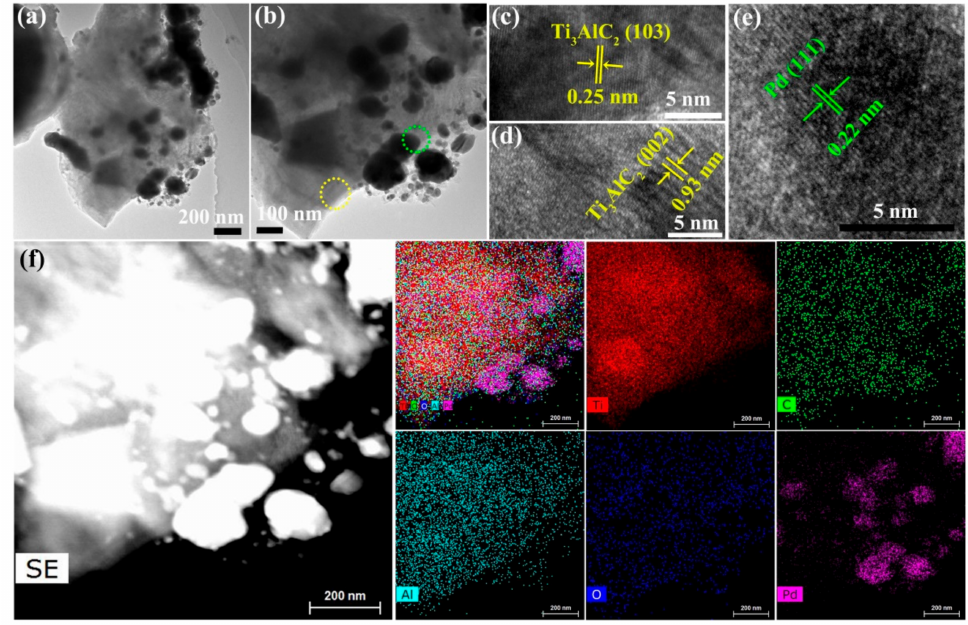
Figure 3. ( a , b ) TEM, ( c – e ) HRTEM and ( f ) EDX elemental mapping images of Ti 3 AlC 2 /Pd-3% catalyst. (The yellow circle in ( b ) focuses on Ti 3 AlC 2 phase shown in ( c , d ), and the green circle focuses on Pd phase shown in ( e